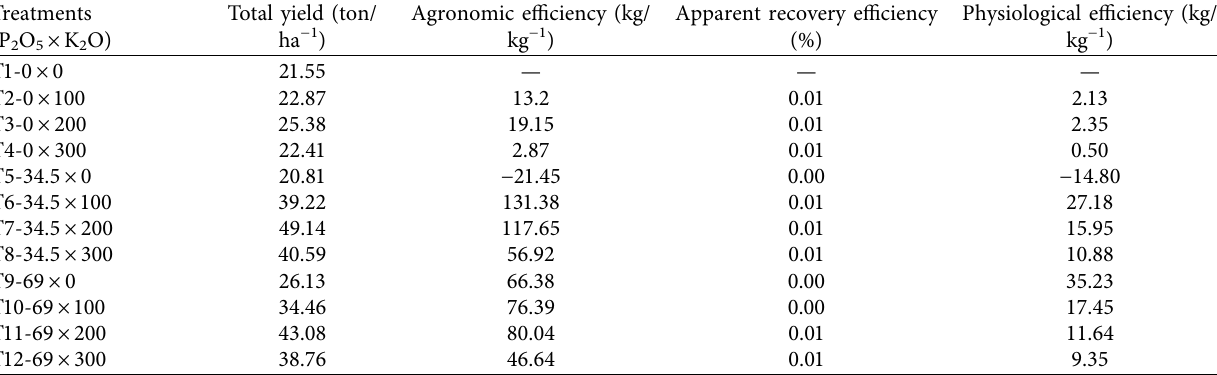
Table 5: Phosphorus and potassium use efficiency of potato crop (Belete var.) for the interaction effects of phosphorus and potassium fertilizers. Treatments